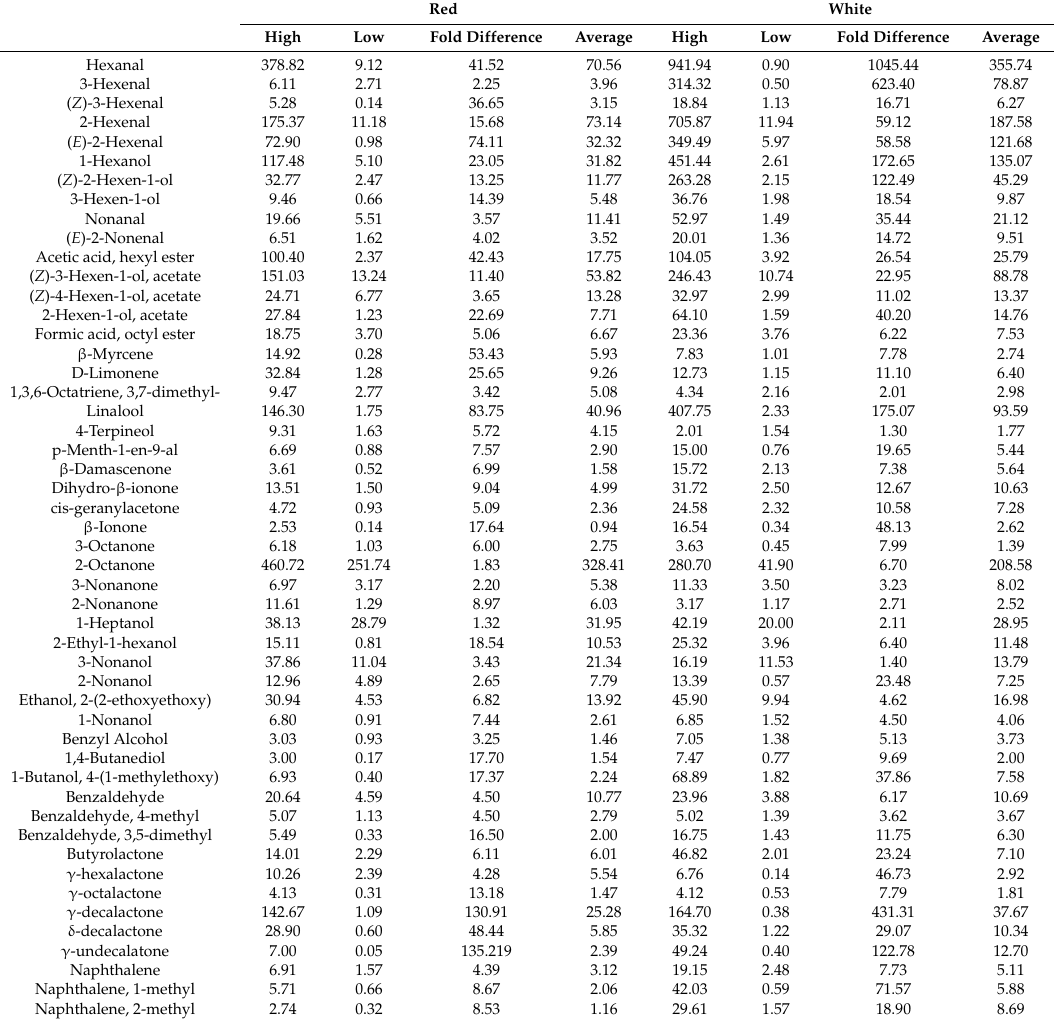
Table 2. Observed variation in volatile compounds (ng/g · FW) in peach fruit.